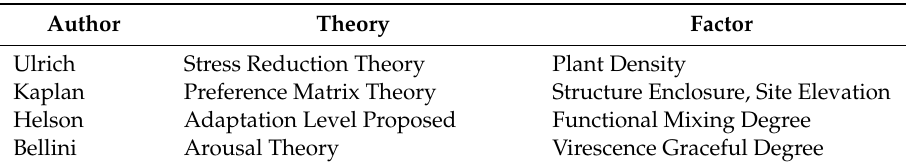
Table 1. Influencing factors used in this